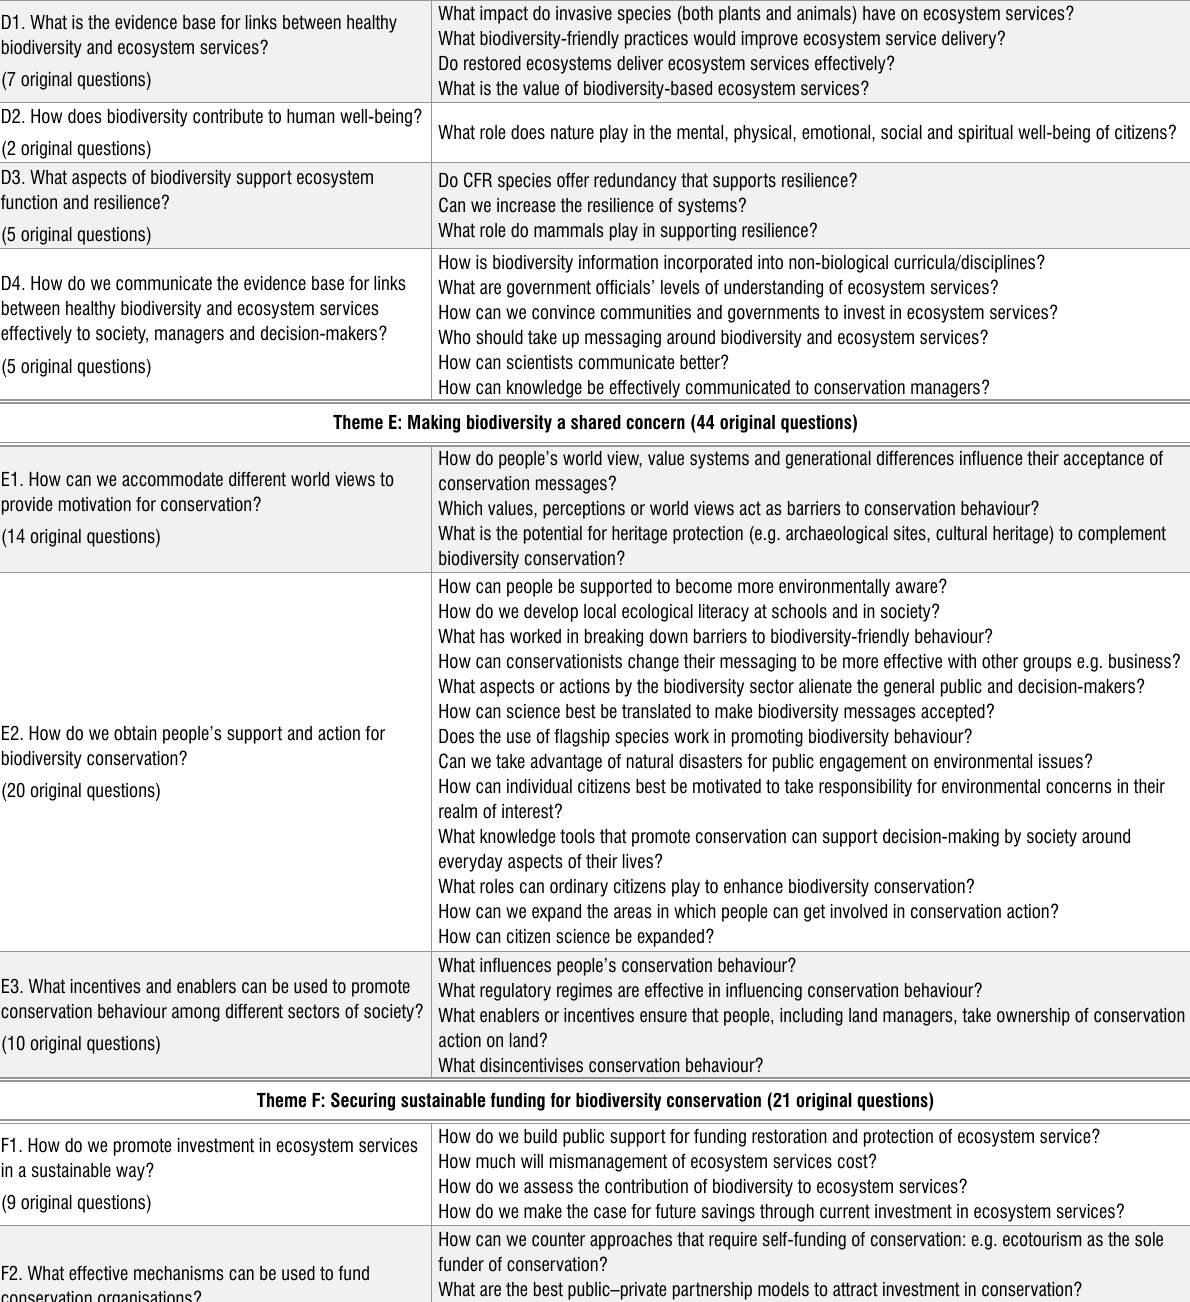
Table 1: Theme D: Making the case that biodiversity supports critical ecosystem services (19 original questions)